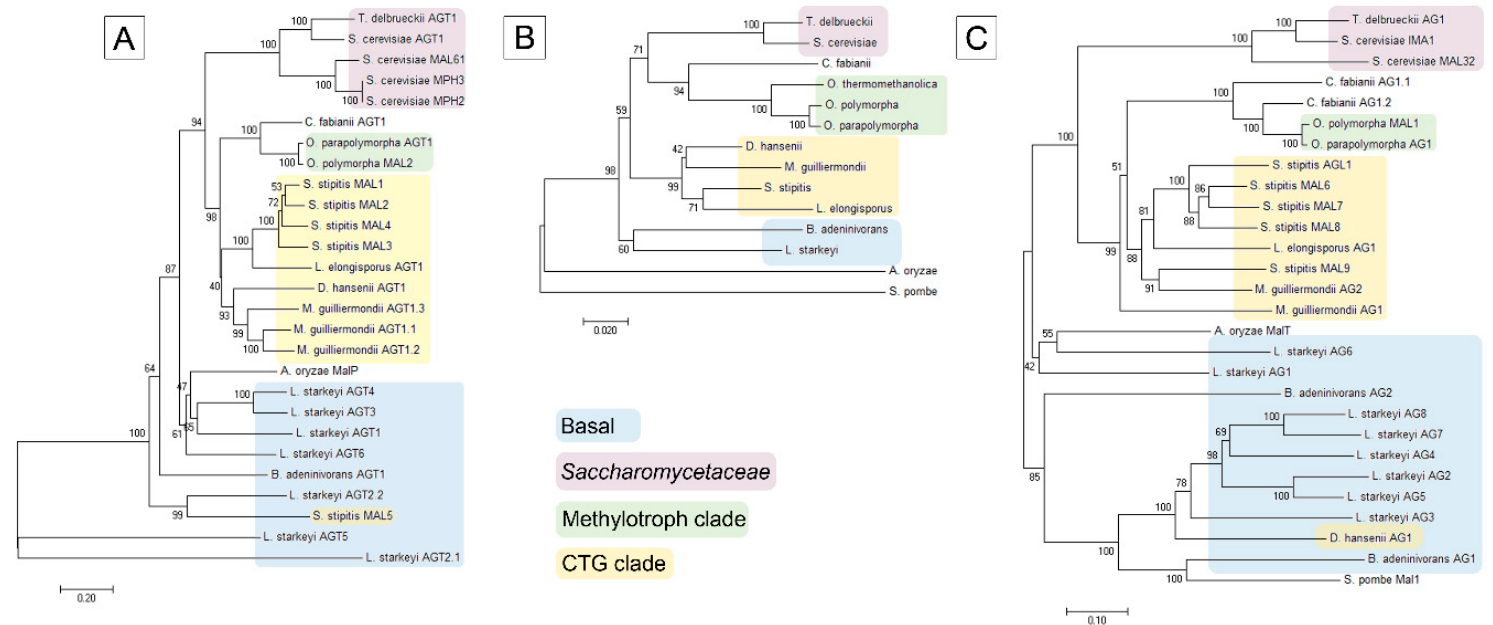
Figure 2. Phylogram of α -glucoside transporters (AGT) ( A ); α -glucosidases (AG) ( C ); and respective host species ( B ). See the Materials and Methods section for details. The scale bar in panels ( A , C ) indicates the number of substitutions per amino acid site, the scale bar in panel ( B ) indicates the number of base substitutions per site. The subgroups of Saccharomycotina according to [60] are designated by different background coloring.